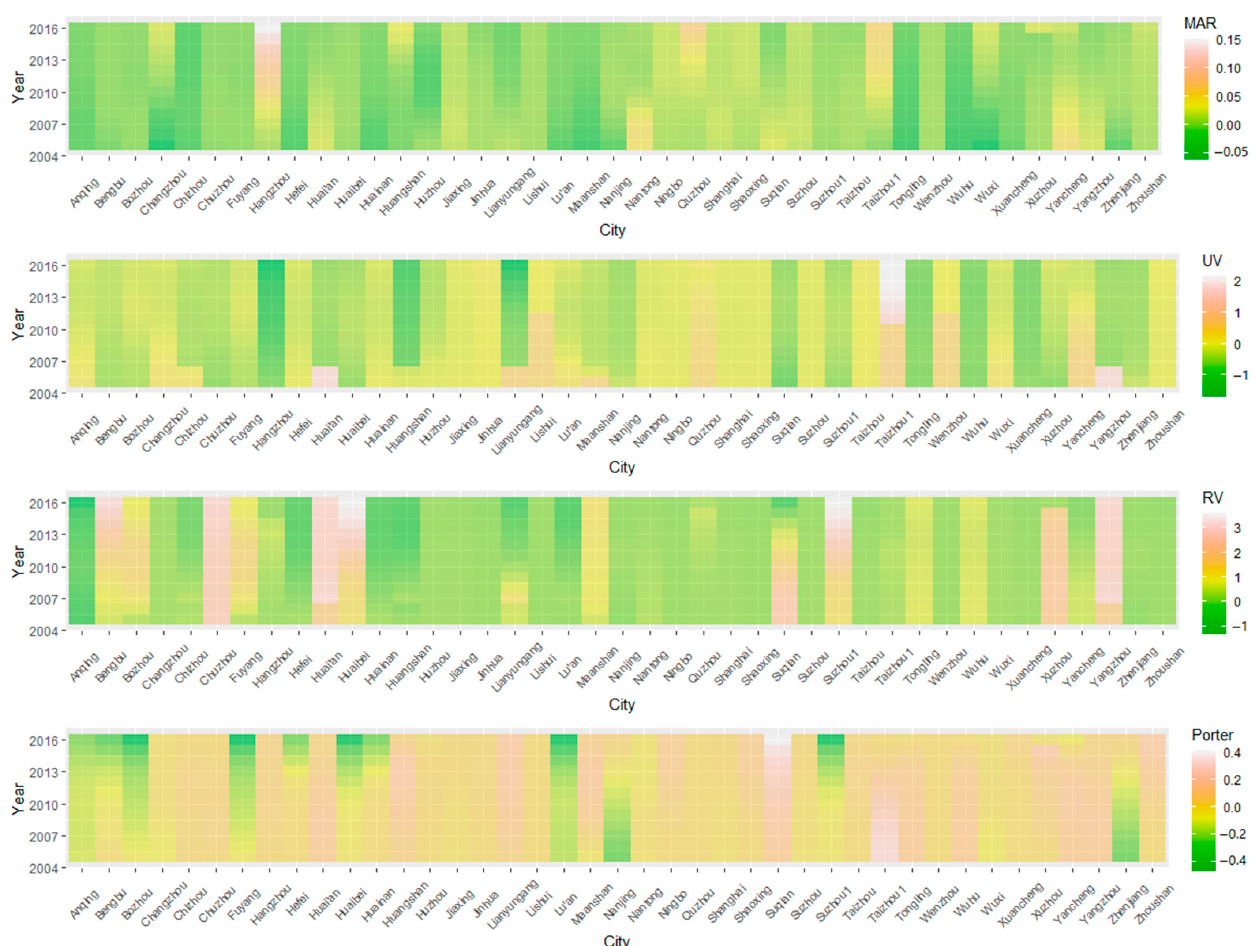
Figure 8. Spatiotemporal distribution of Porter.